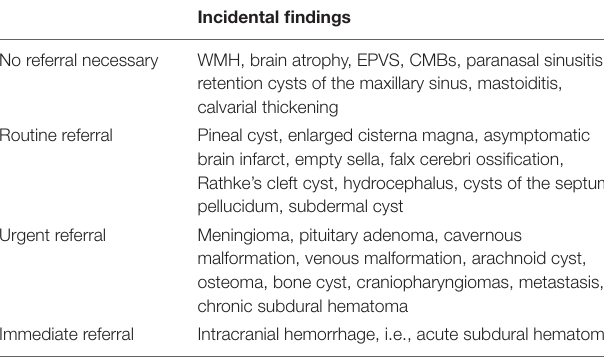
TABLE 1 | Classifications of incidental